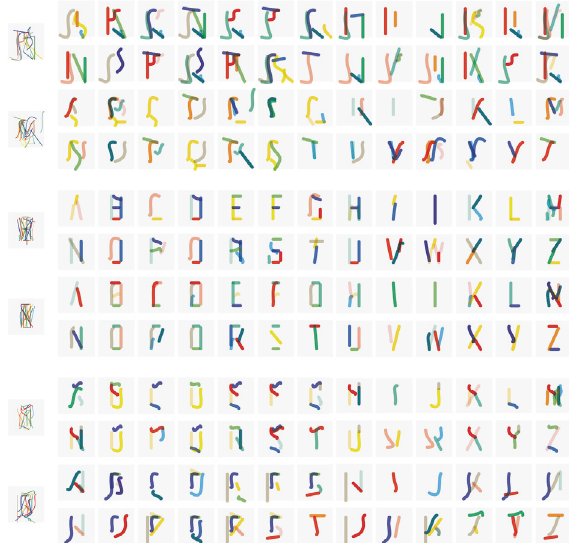
Figure 9: Typical results evolved in different runs of fitRec (top group), fitSim (middle group) and fitHybrid (bottom group). To bet- ter identify each element of the stencils (left) in the corresponding glyphs (right), a random colour is used for each element.